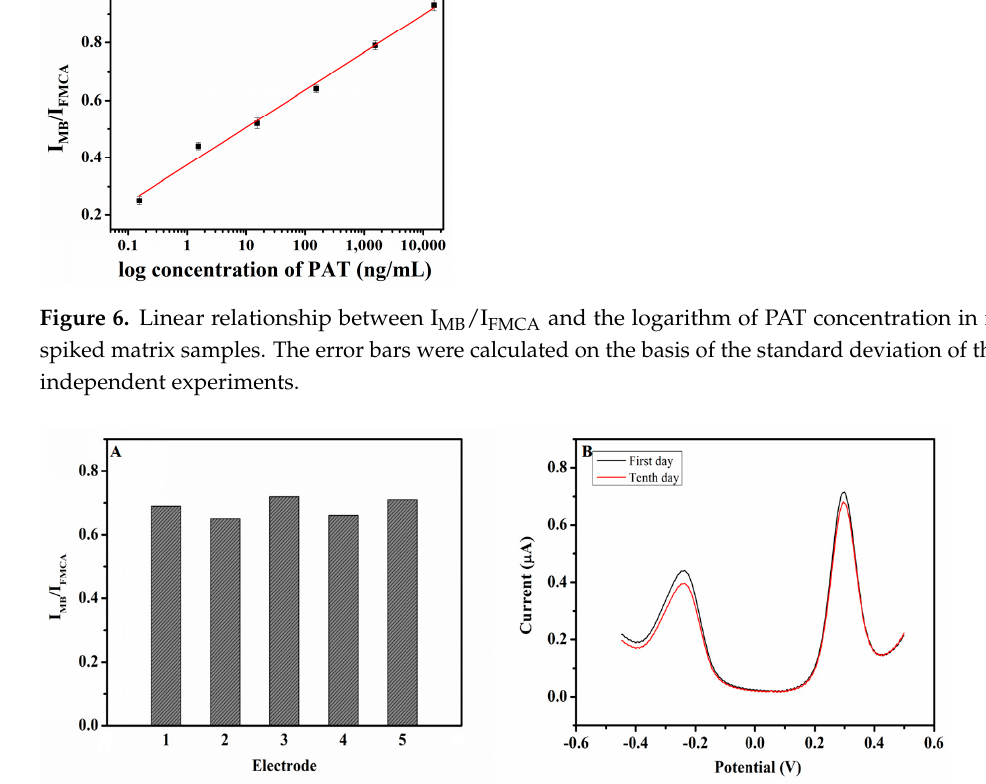
Figure 7. ( A ) Reproducibility of the aptasensor for 0.154 μ g/mL PAT detection. The numbers 1–5 represent five independent electrodes, respectively. ( B ) Stability of the aptasensor for 0.154 μ g/mL PAT detection.